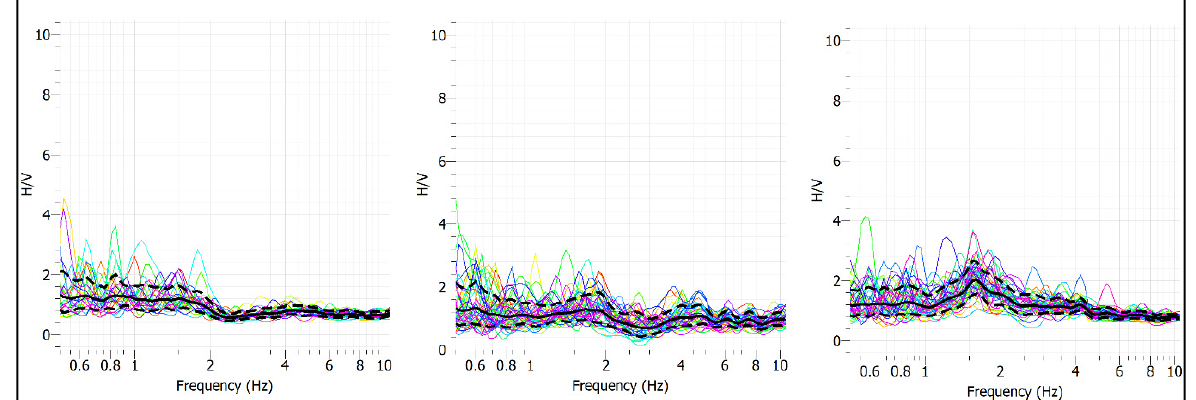
Figure 15. H/V curves in three different points in Santiago with dense soils.